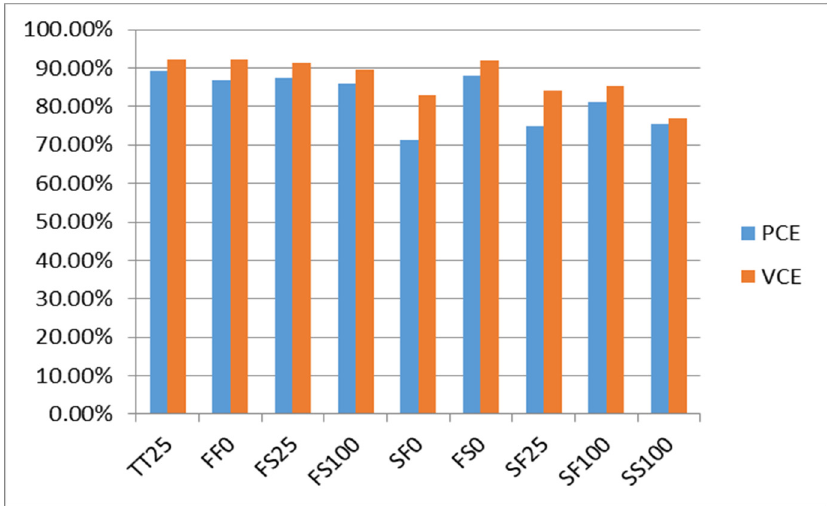
Figure 18 . Rectifier conversion efficiency under different process corners. Figure 18. Rectifier conversion e ffi ciency under di ff erent process corners.